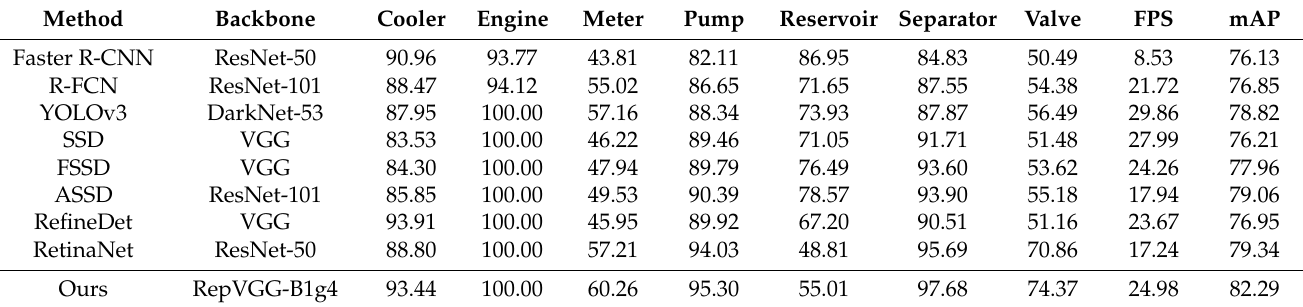
Table 4. Comparison of the test detection results with the other classical methods on the AEMER